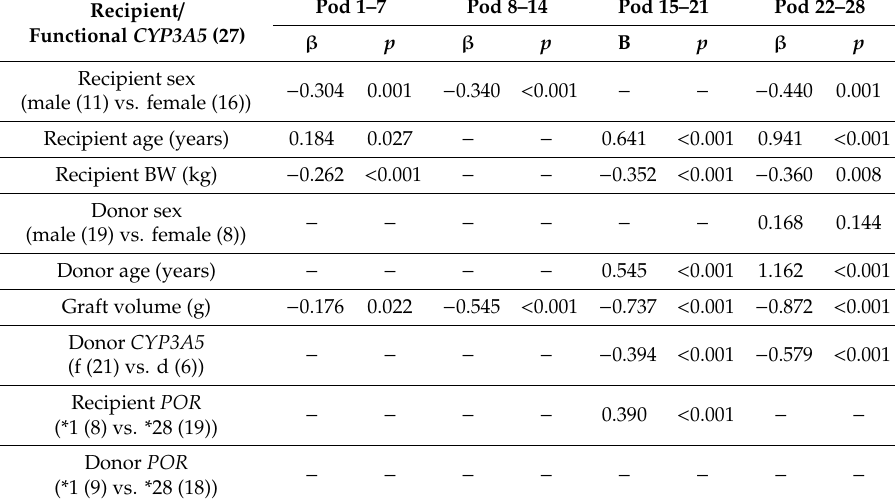
Table 5. Multiple regression analysis of cases in which recipients had functional